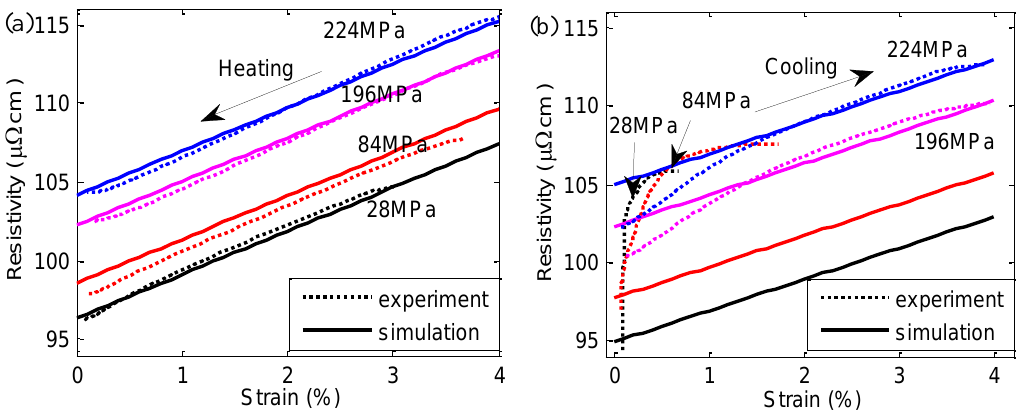
Figure 9. Simulation and experimental results of ER vs . strain curves during M A  ( a ) and A M  ( b ) transformation at various constant